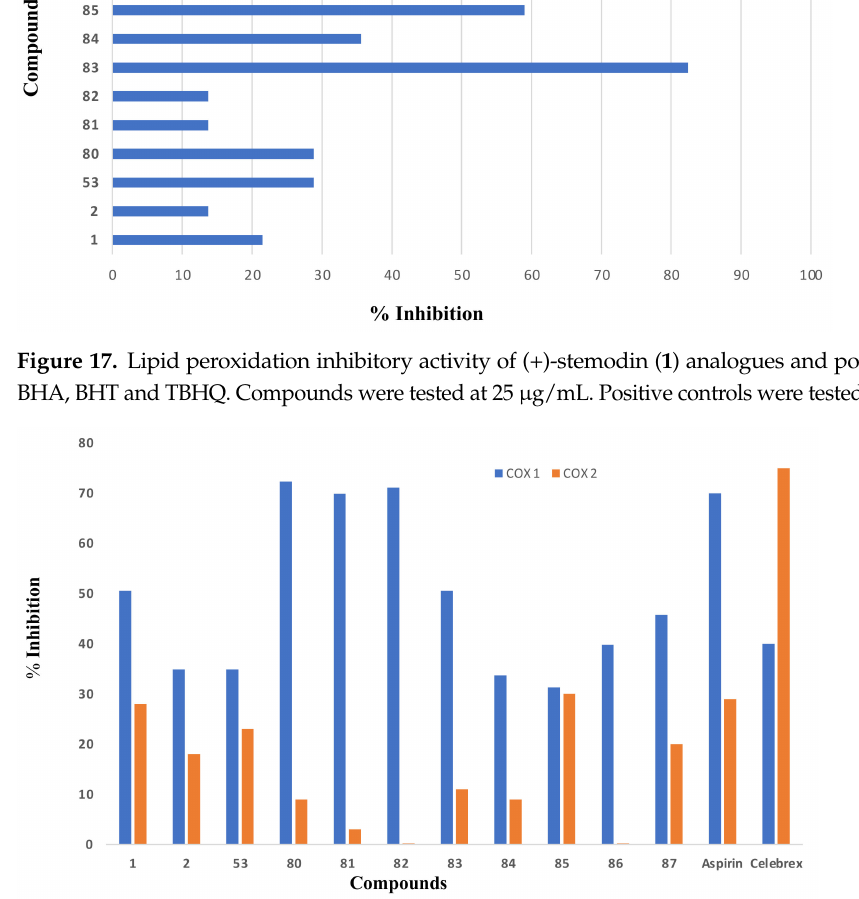
Figure 18. Cyclooxygenase enzyme-1 and -2 inhibitory activities of (+)-stemodin ( 1 ) analogues. Compounds were tested at 25 µ g/mL. Positive controls Aspirin and Celebrex TM were tested at 60 µ M and 26 nM concentrations